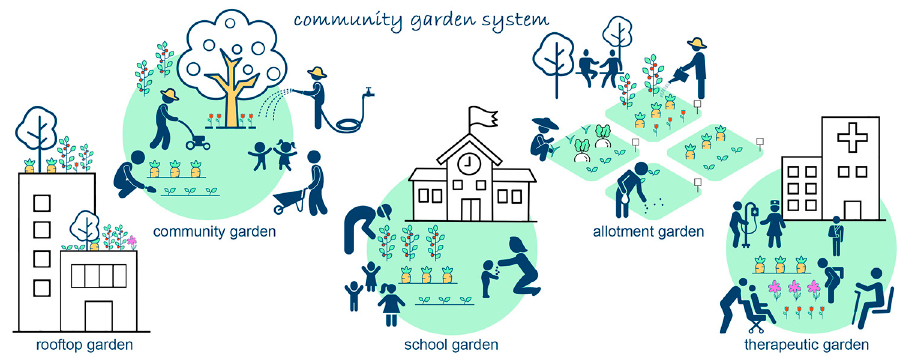
Figure 1. Illustrations of the types of gardens included in this study.